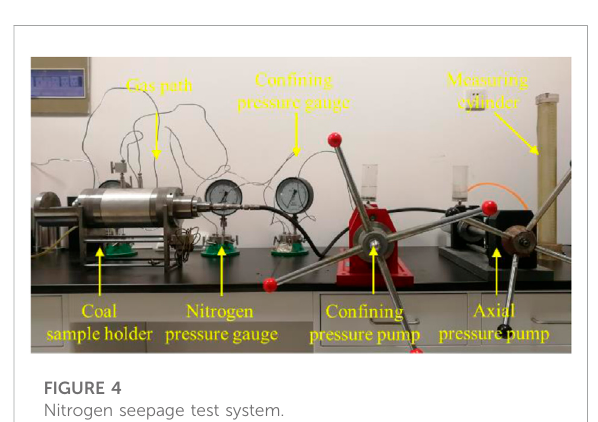
FIGURE 4 Nitrogen seepage test